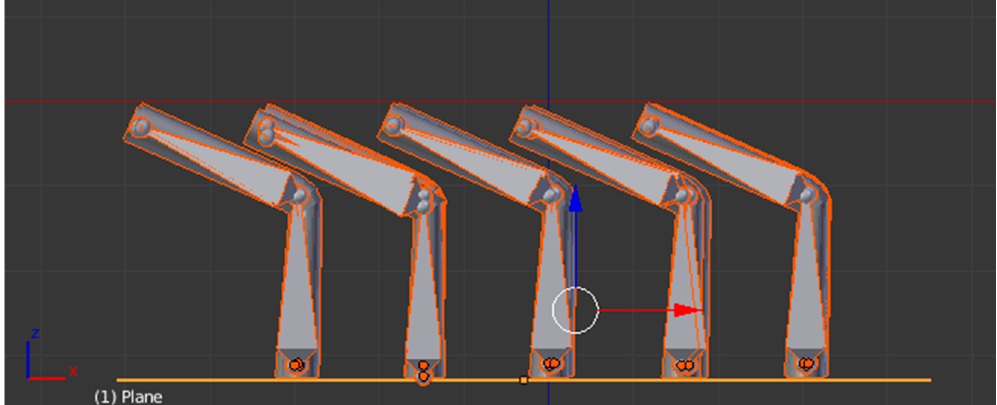
Figure 4. Example of the rigging effect for the middle bone: the tilt of the hairs is a parameter that can be adjust by the user.